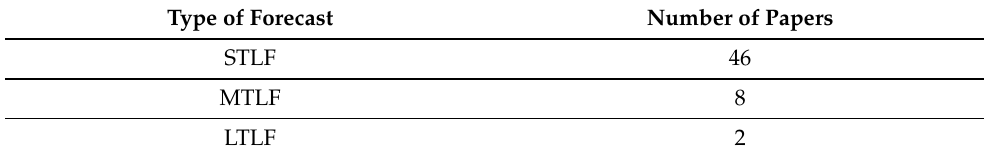
Table 2. Type of used input